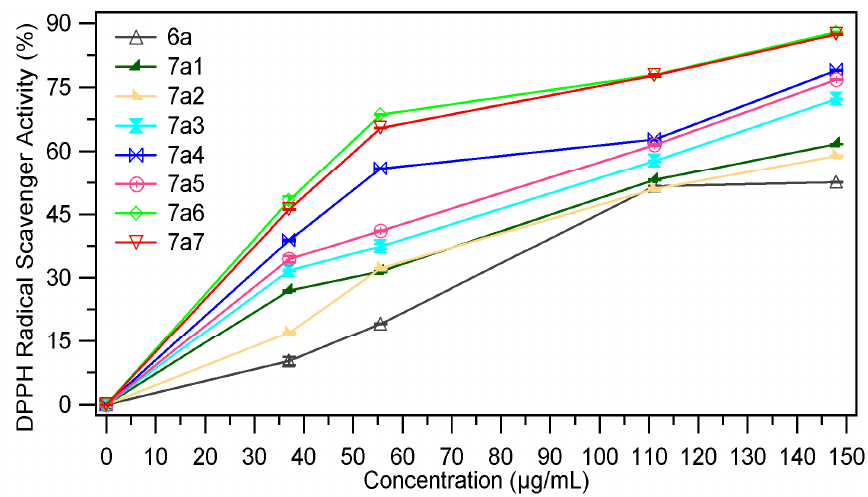
in ref. to 6a 1–7